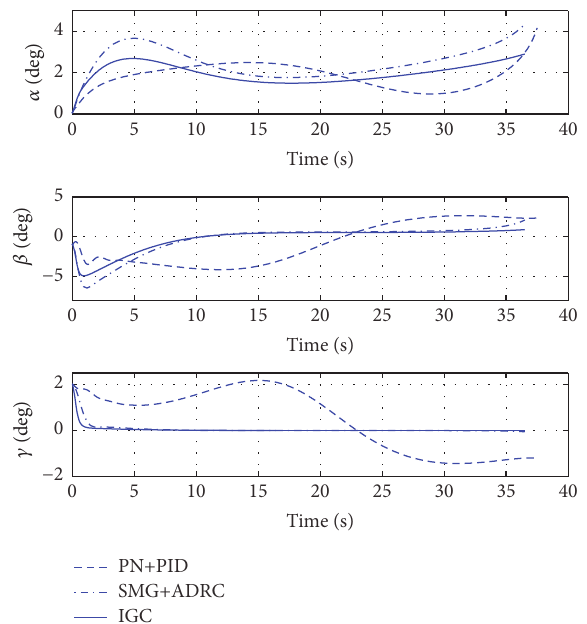
Figure 4: The range of attack angle, sideslip angle, and roll angle with respect to time in Scenario 1.